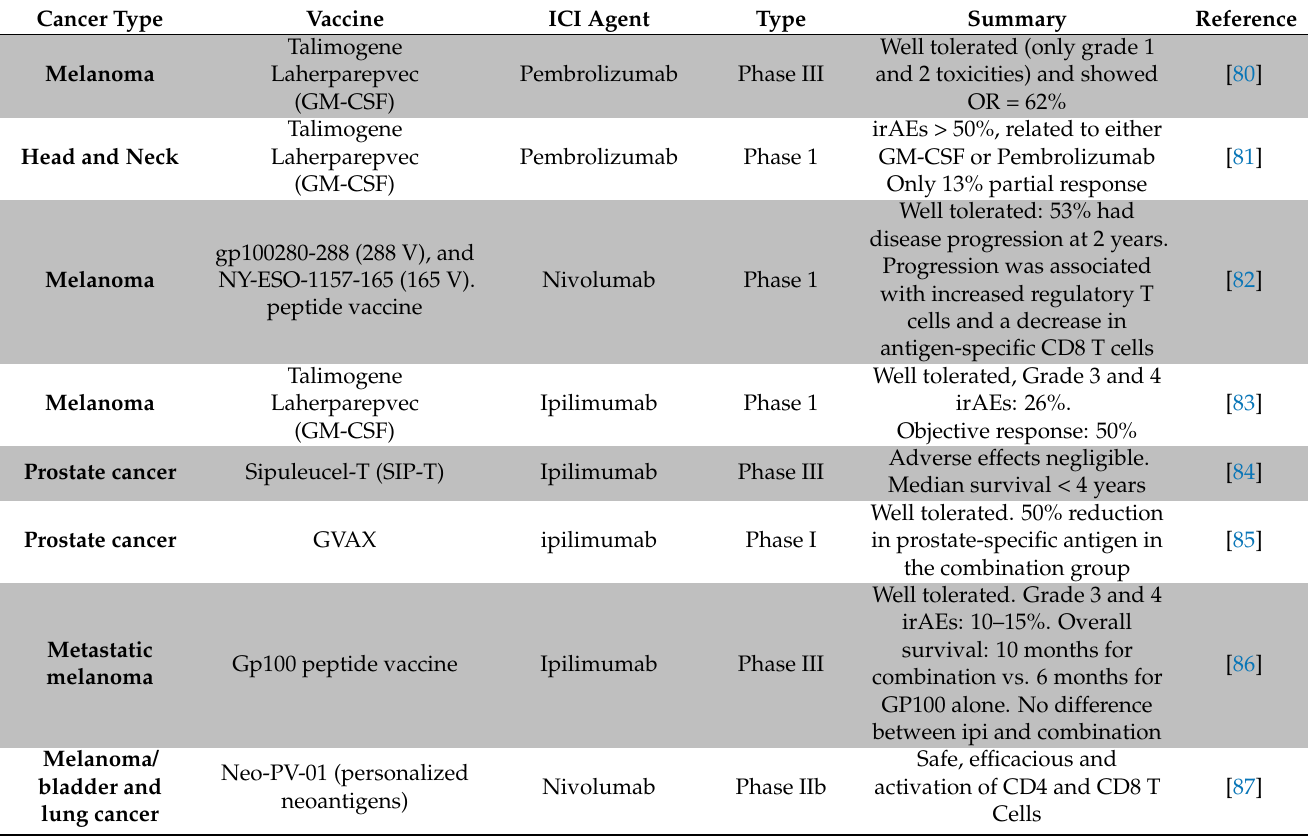
Table 2. Combination therapies of cancer vaccine and ICIs in clinical trials. irAE: immune-related adverse events. Cancer